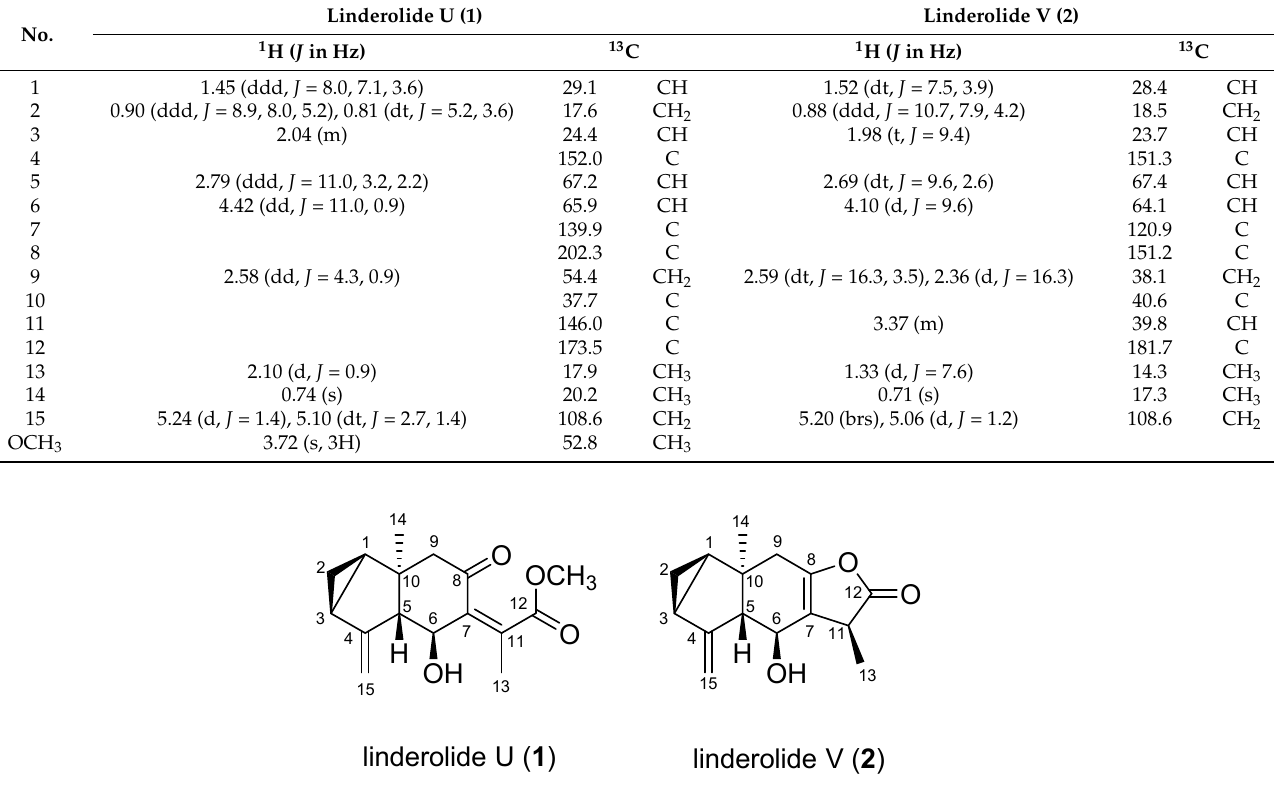
Table 3. 1 H (400 MHz) and 13 C NMR (100 MHz) data for compounds 1 and 2 in CD3OD ( δ in ppm, J values in parentheses). No.